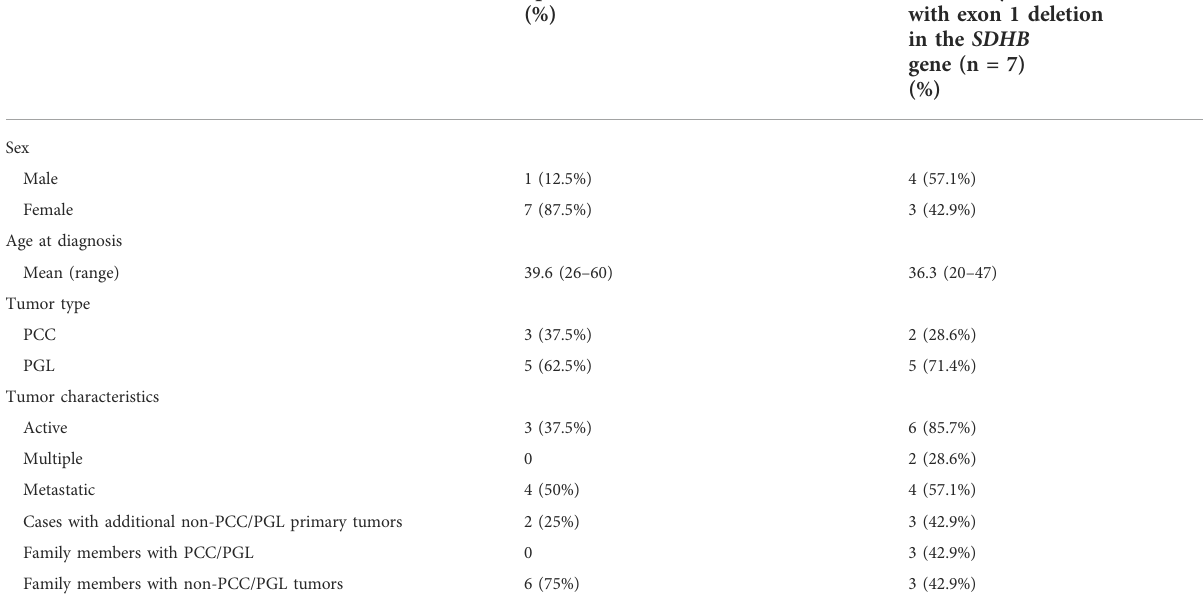
TABLE 3 Characteristics of adult patients with sporadic PCC/PGL and hereditary PGL/PCC associated with exon 1 deletion in the SDHB